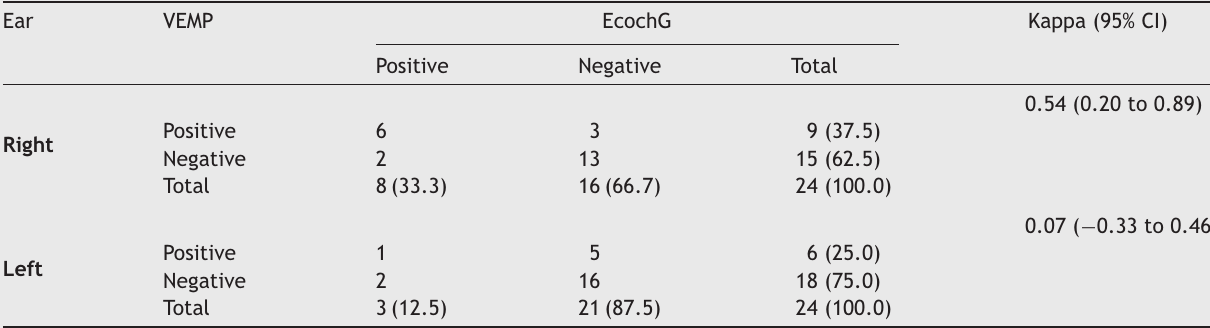
Agreement between diagnostic